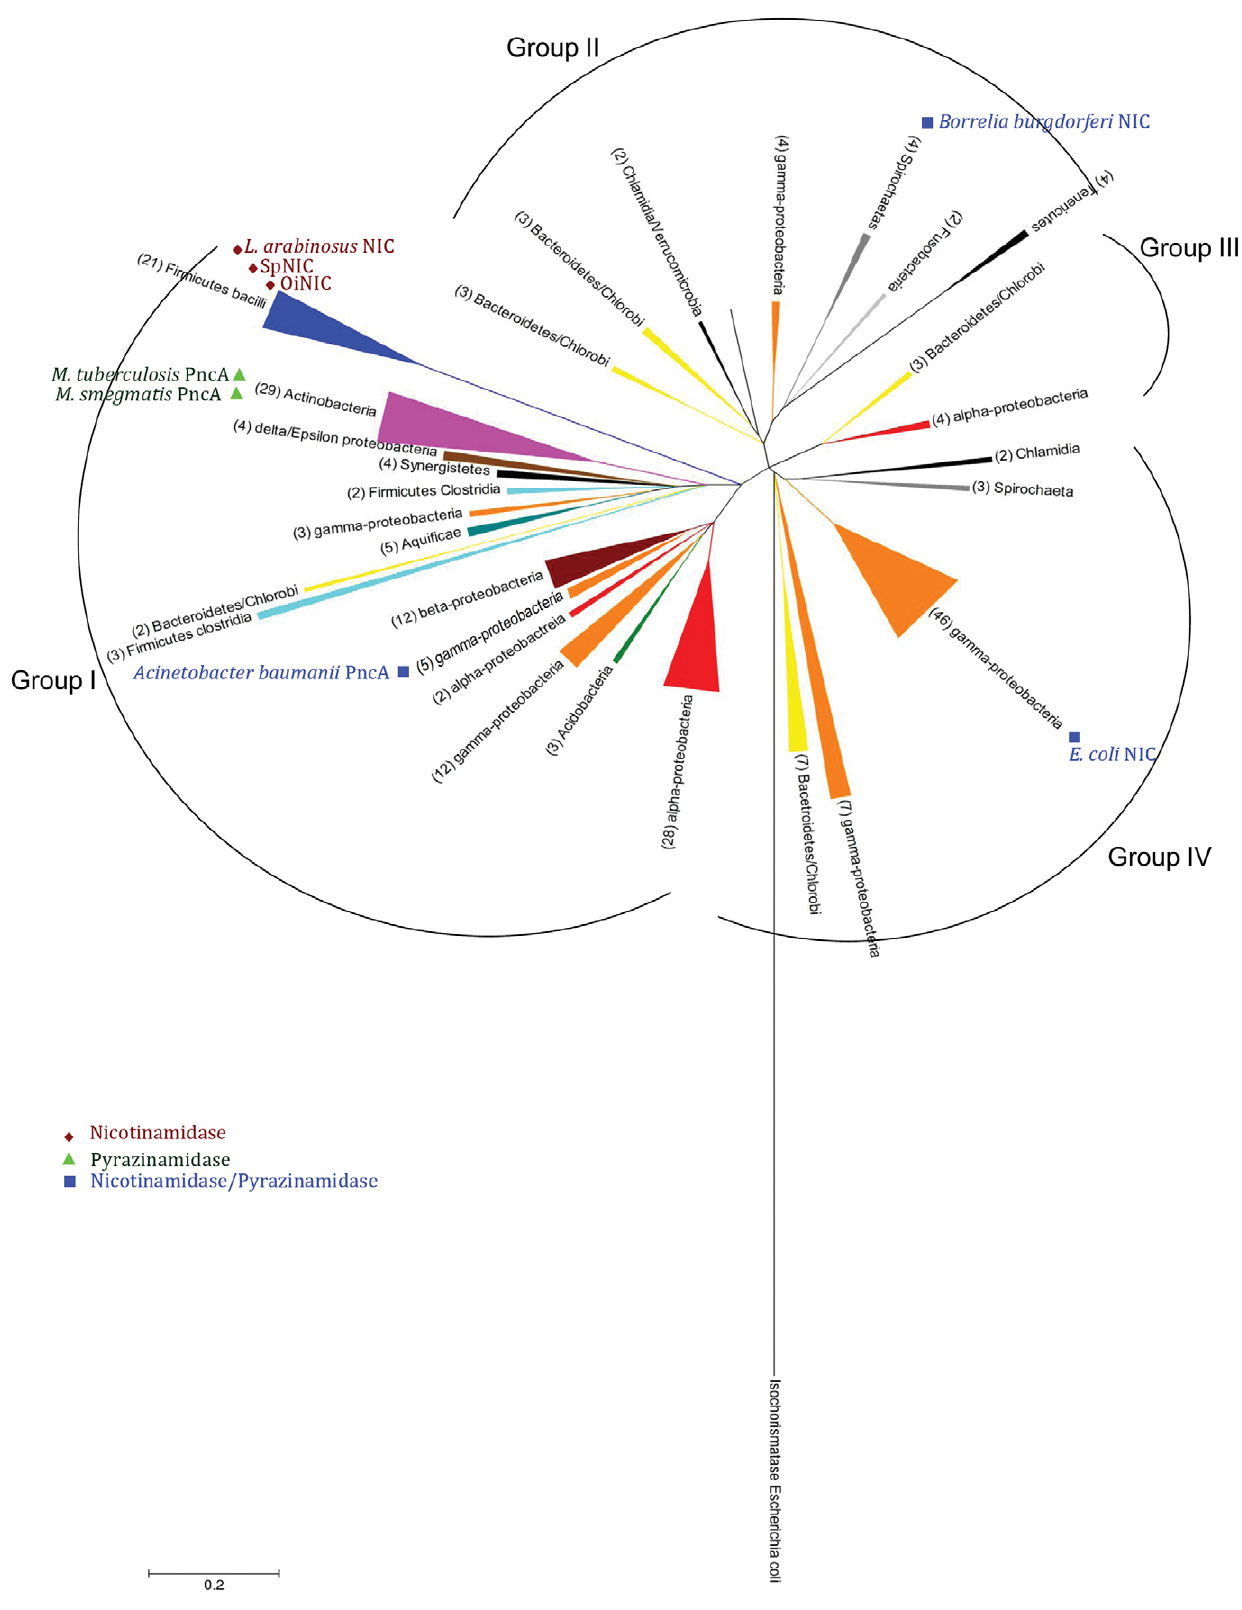
Figure 7. Phylogenetic distribution of bacterial nicotinamidases. For reasons of clarity, branches are shown compressed as triangles. The scale bar at the lower left indicates the rate of amino acids substitutions. The triangle base corresponds to the number of compressed sequences involved, which is also shown in parentheses. The triangle height corresponds to evolutionary distance. The bacterial nicotinamidase sequences used